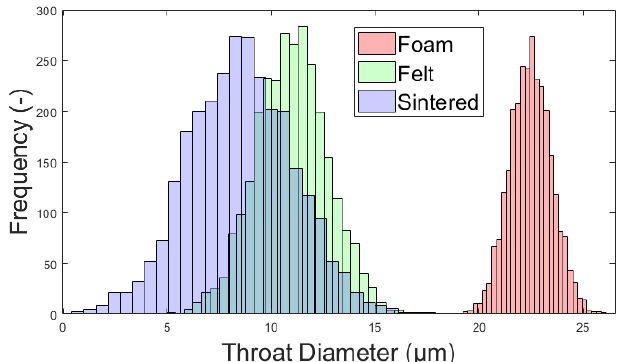
Figure 14. PSDs used for different PTL types with standard deviations: 1.0 μ m for foam, 1.7 μ m for felt and 2.5 μ m for sintered.